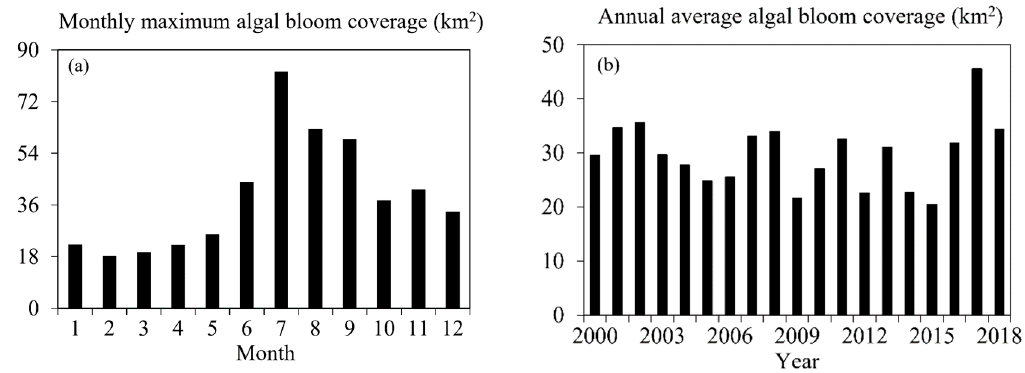
Figure 7. Algal bloom areas changes in Lake Dianchi. ( a ) MaxABs from January to December; ( b ) annual variations from 2000 to 2018.